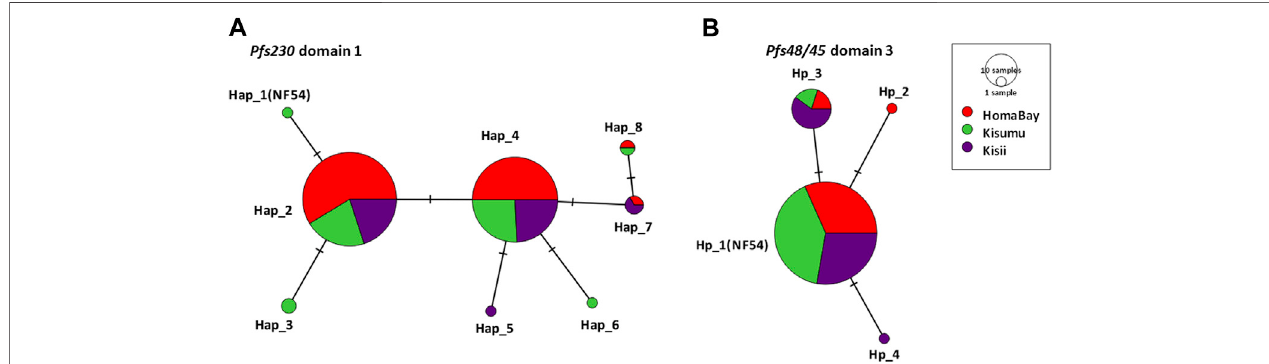
FIGURE 2 | TCS-network analysis of the relationship of haplotypes based on the of Pfs230 domain one and Pfs48/45 domain three from parasites in malaria- endemic and epidemic-prone regions of western Kenya. (A) . represents haplotypes based on observed sequence variation in Pfs230 D1 whereas (B) represents haplotypesin Pfs48/45 D3.Thenetworkshowsthedistributionofhaplotypewithinmalaria-endemicHomaBay(red)andKisumu(Chulaimbo)(green)aswellasepidemic Kisiihighland(purple).Thehatchmarksrepresentthenumberofmutationsresultinginaspeci fi chaplotypewhereasthesizeofthecircleequatestothefrequencyof the observedhaplotypes.HaplotypeslabelledHap_1(NF54)for Pfs230 D1and Hp-1(NF54) for Pfs48/45 D3 lackedmutatedlocusand have 100%sequence identityto laboratory strain NF54 or 3D7. Nucleotide sequences of all haplotypes were submitted to GenBank (accession: MW624857-